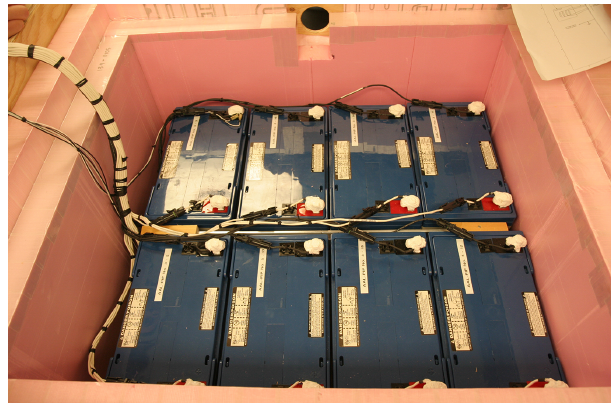
Figure 8. The top layer of two layers of batteries installed in the battery box. Note the aluminum battery heater plate between the two battery rows. Also note the custom wiring harness with Delphi connectors used to connect the batteries in